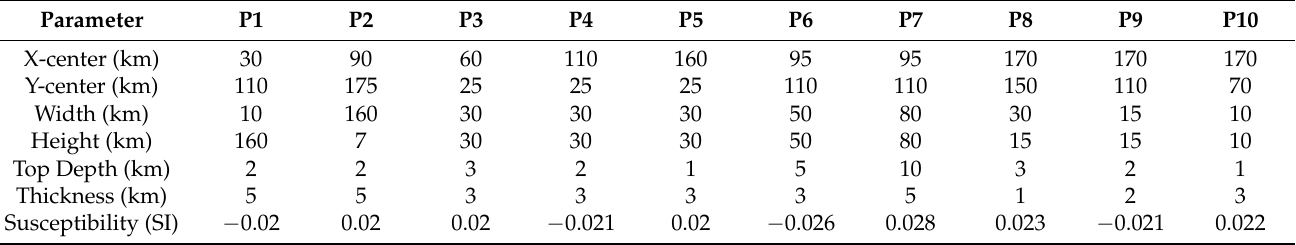
Table 2. Geometry and magnetization parameters of the 3D synthetic